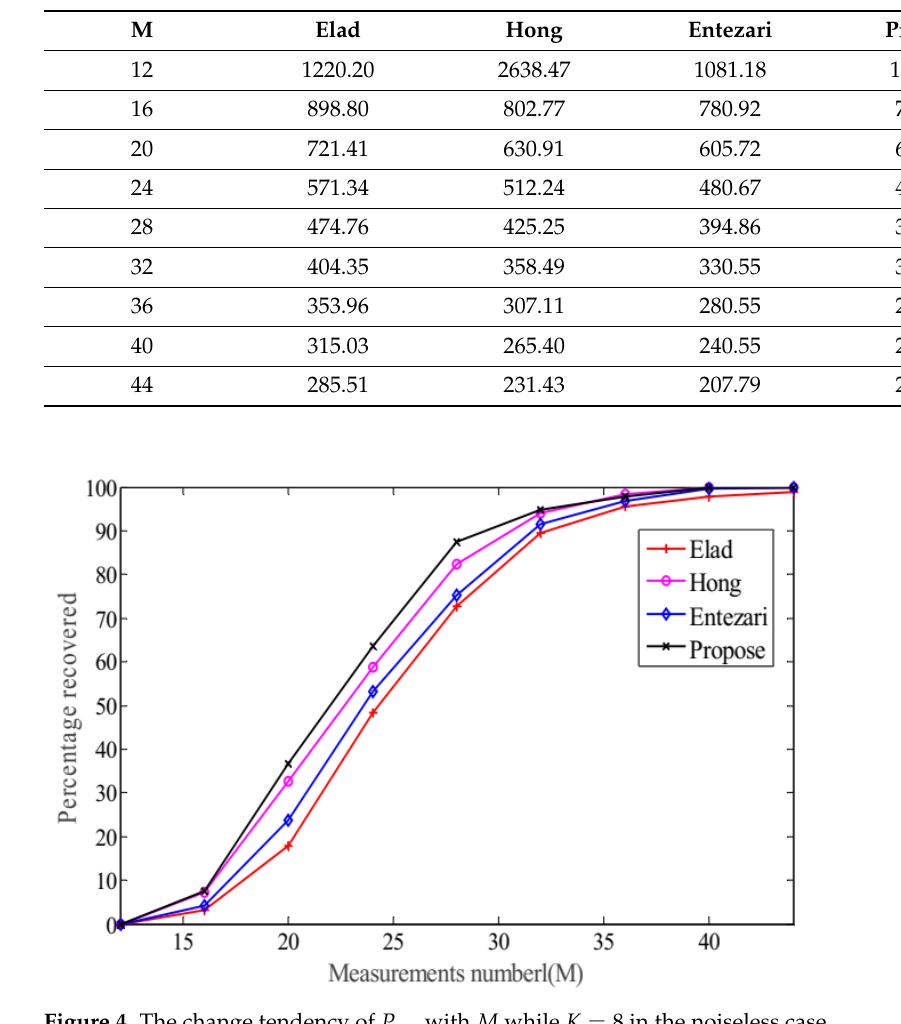
Table 3. µ all by Elad, Hong, Entezari, and proposed method versus measurement dimension M .